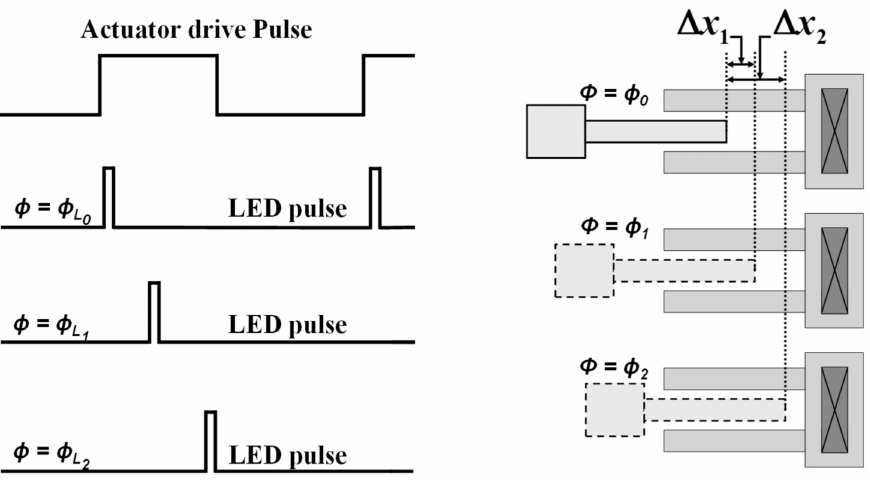
Figure 2. Schematic representation of stroboscopic imaging by phase delayed imaging light-emitting diode (LED)